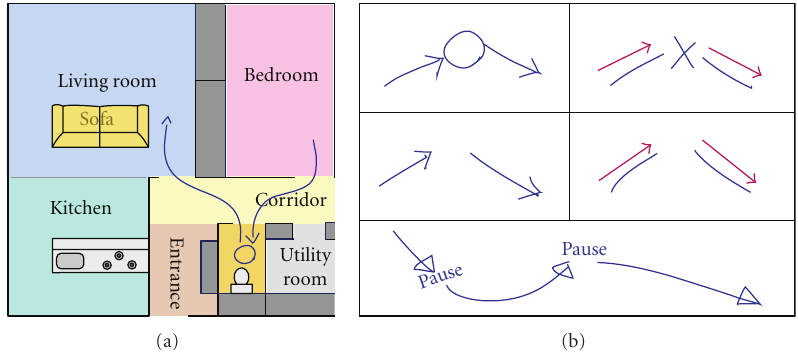
Figure 9: Sketch notations denoting a pause in movement.